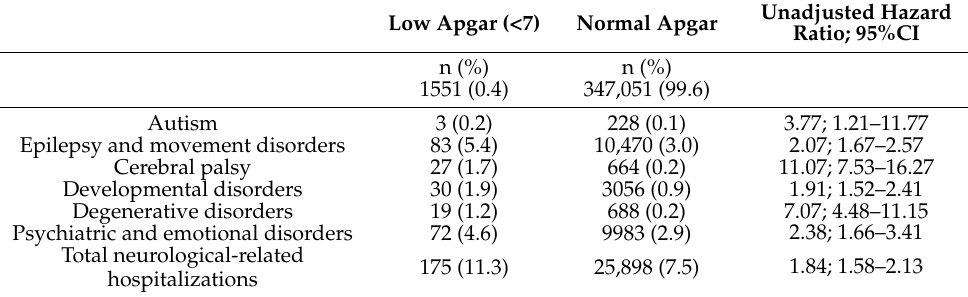
Table 2. Selected neurological morbidities with normal or low 5 min Apgar scores.